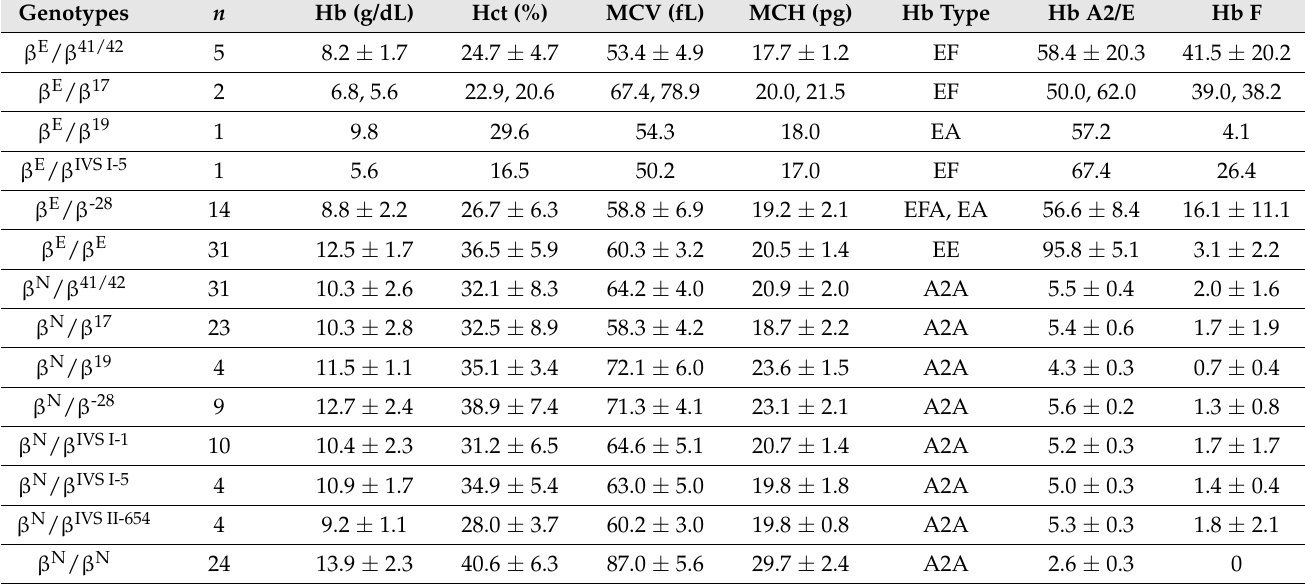
Table 1. A total of 163 unrelated samples with hematological data (Hb, Hct, MCV, MCH, DCIP), Hb analysis and β -globin gene genotype. The values are indicated as mean with standard deviation or as raw data where